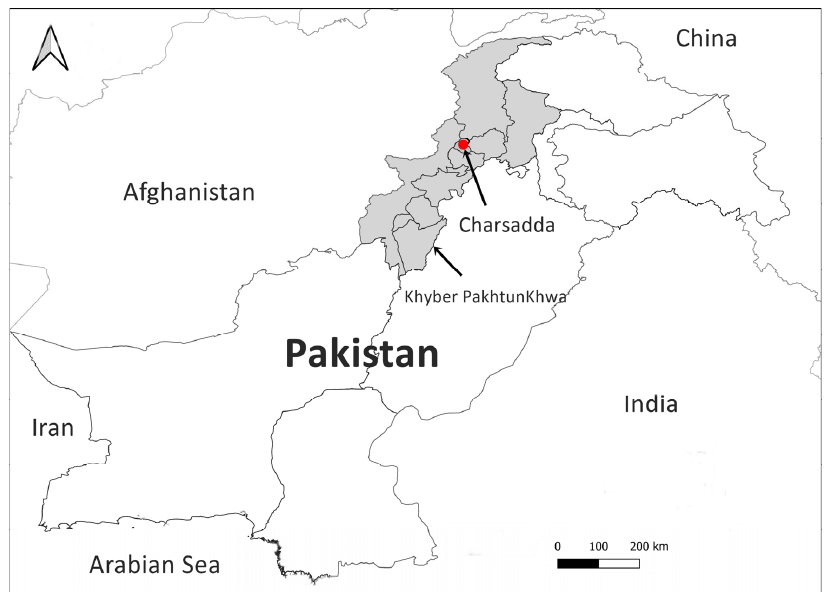
Figure 1. Map of the study area Charsadda, Khyber Pakhtunkhwa (highlighted) Pakistan.